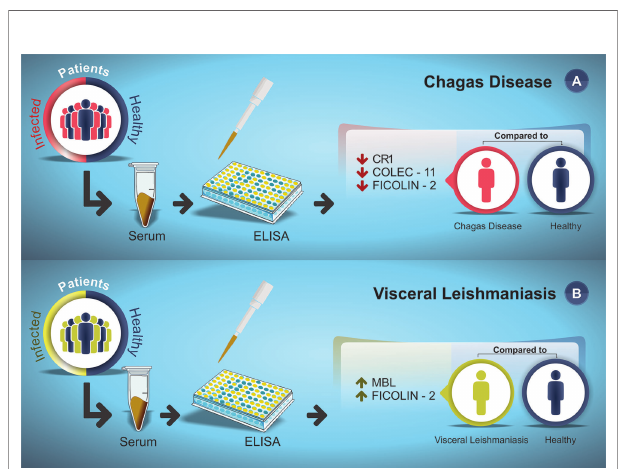
FIGURE 2 | Susceptibility pro fi le for CD (A) and VL (B) according to serum protein expression levels reported in the articles included in this systematic review. (A) CD patients (red) and healthy individuals (dark blue) serum levels were measured by ELISA assay. (B) VL patients (green) and healthy individuals (dark blue) serum levels were measured by ELISA assay. The arrows indicate the increase ( ↑ ) or decrease ( ↓ ) protein level in the serum of patients compared to the healthy control